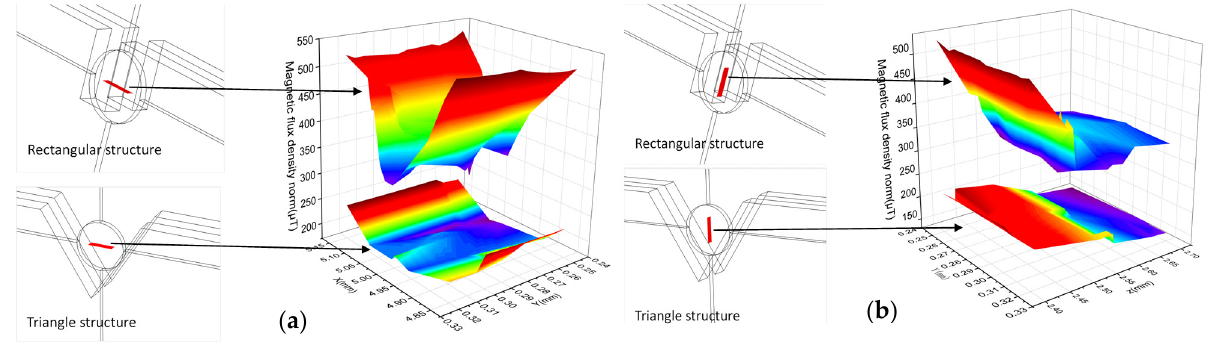
Figure 7. Distribution of magnetic fields in different directions in the induction area: ( a ) Horizontal magnetic field distribution; ( b ) Magnetic field distribution in the vertical direction.